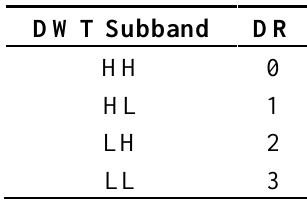
Table 4. Data Relevance for a 1-level 2D DWT.